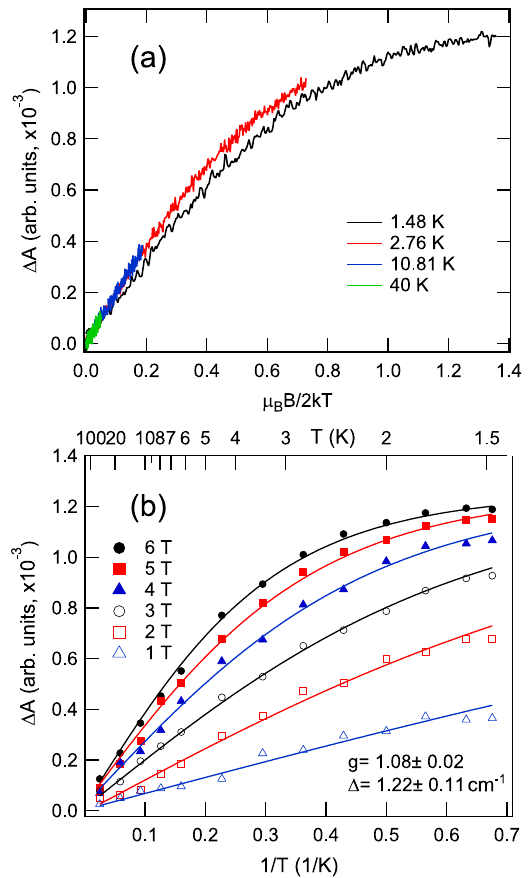
Figure 3. Magnetic field ( a ) and temperature ( b ) dependences of MCD at 465 nm (MCD and absorption band D1). Solid lines in ( b ) represent the fit by Eq. (2).